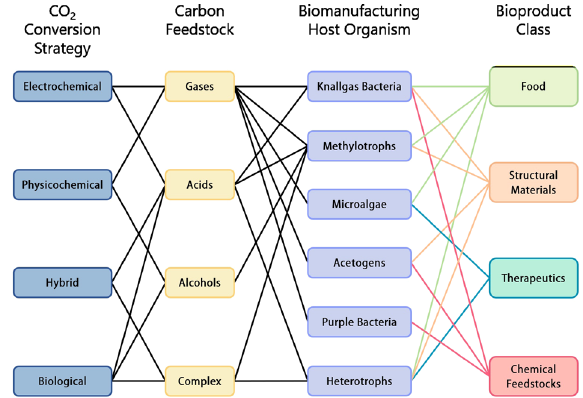
Fig. 3 | Breakdown of available routes for bioproduction of inventory items from carbon dioxide — either as in situ or recovered resource. Connecting lines represent possible paths for carbon-compound conversion of intermediates to products. Usability of different feedstocks is tied to nutritional mode of the microbial host organism (more than one nutritional mode is possible for certain organisms). Classes of products are assigned to respective microbes in respect of their metabolism as well as not represented ‘ shadow-characteristics ’ of the chassis (e.g., aerobic/anaerobic, prokaryotic/eukaryotic, metabolic rate, robustness, etc.), ratherthanabilityto(naturally)derivetherespectivecompounds.Productsmayor may not comprise some of the initial feedstocks, hence consecutive runs through this chart to up-cycle carbon are